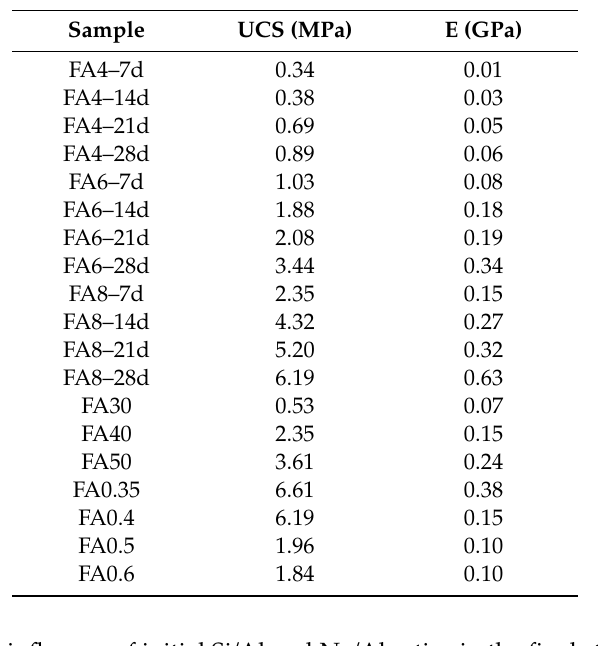
Table 4. Unconfined compressive strength (UCS) and Young’s Modulus (E) for the geopolymers at di ff erent curing